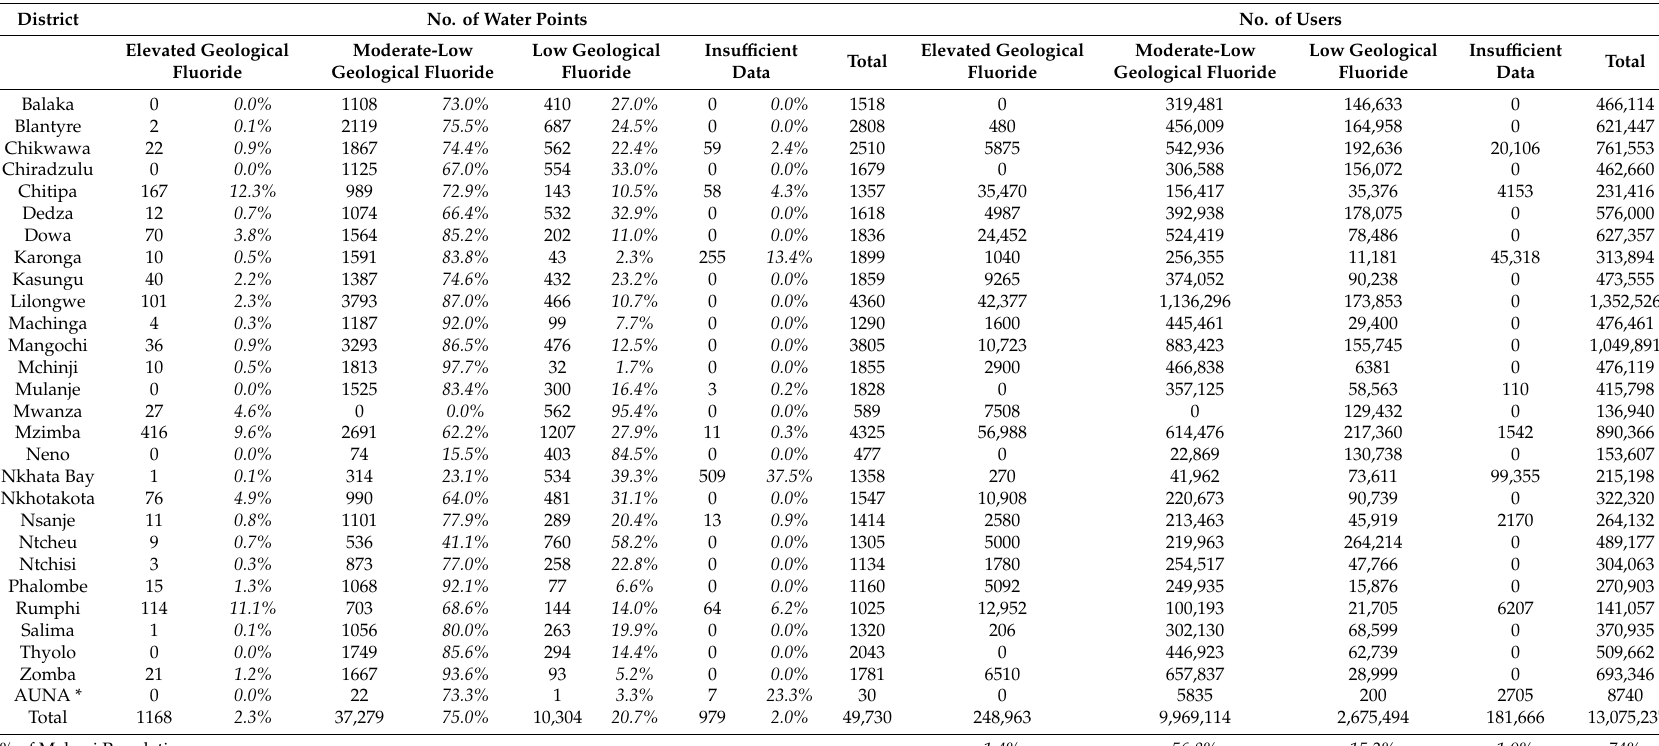
Table 4. Data for the number of water points in each fluoride zone and the corresponding number of people at risk per zone, split per district.